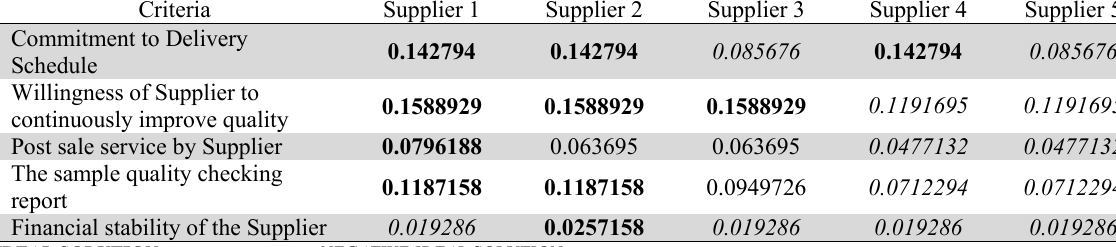
Determining the ideal solution and the negative ideal solution